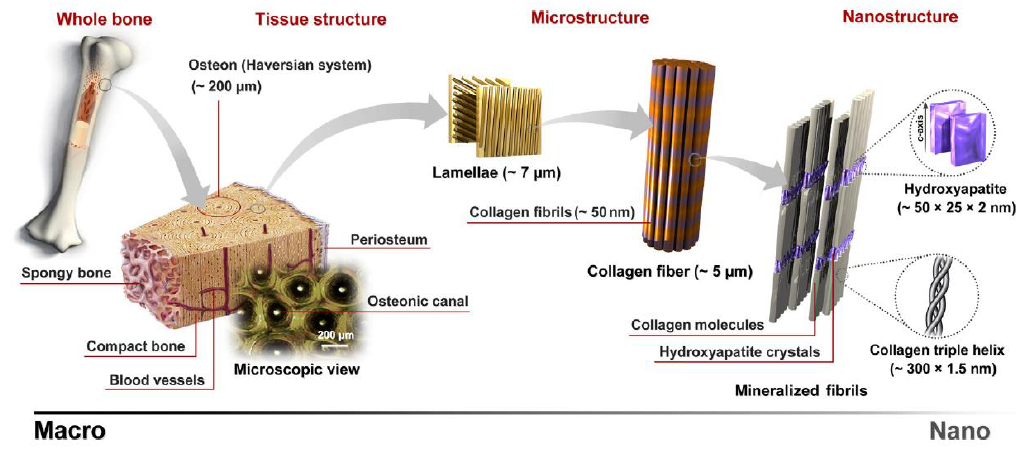
Figure 1. Hierarchical structural organization of the bone [25].